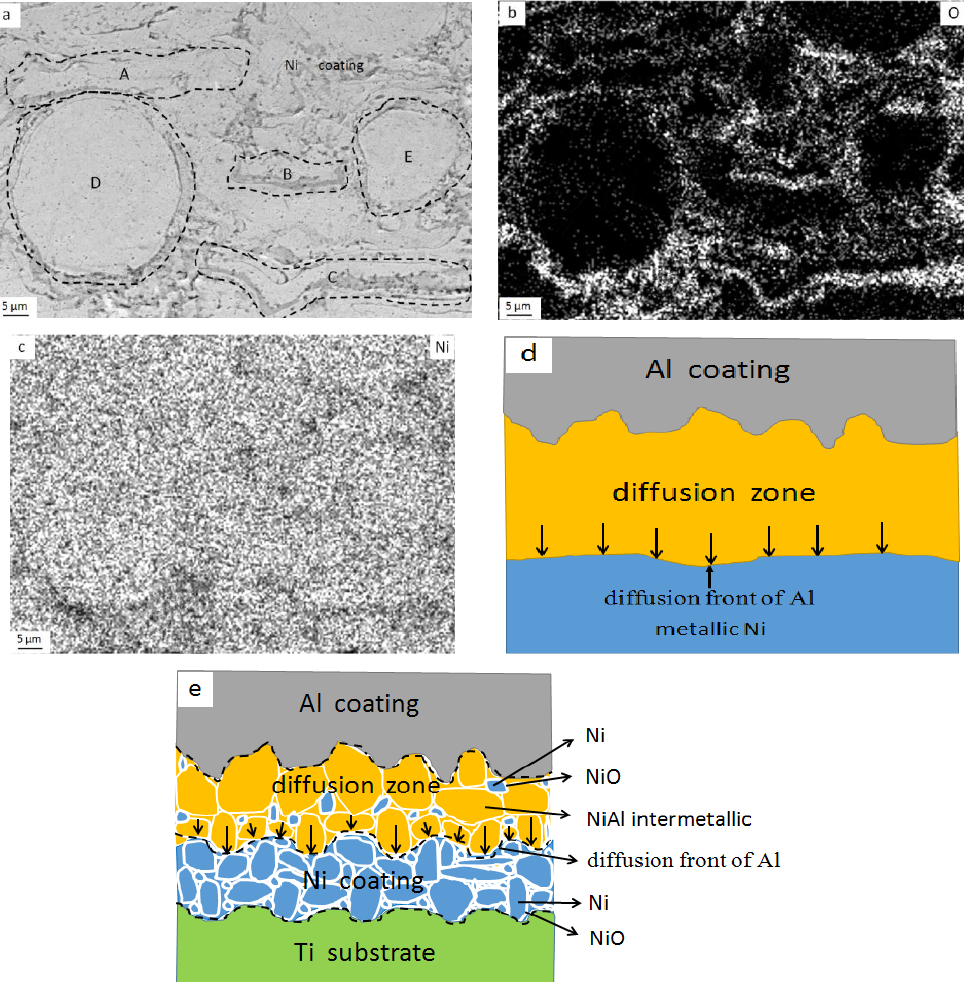
Figure 6. ( a ) Cross-sectional SEM image of Ni coating without heating; ( b , c ) the distributions of elemental O and Ni in ( a ); ( d , e ) schematic diagram of Al/Ni specimen and Al/Ni/Ti specimen after